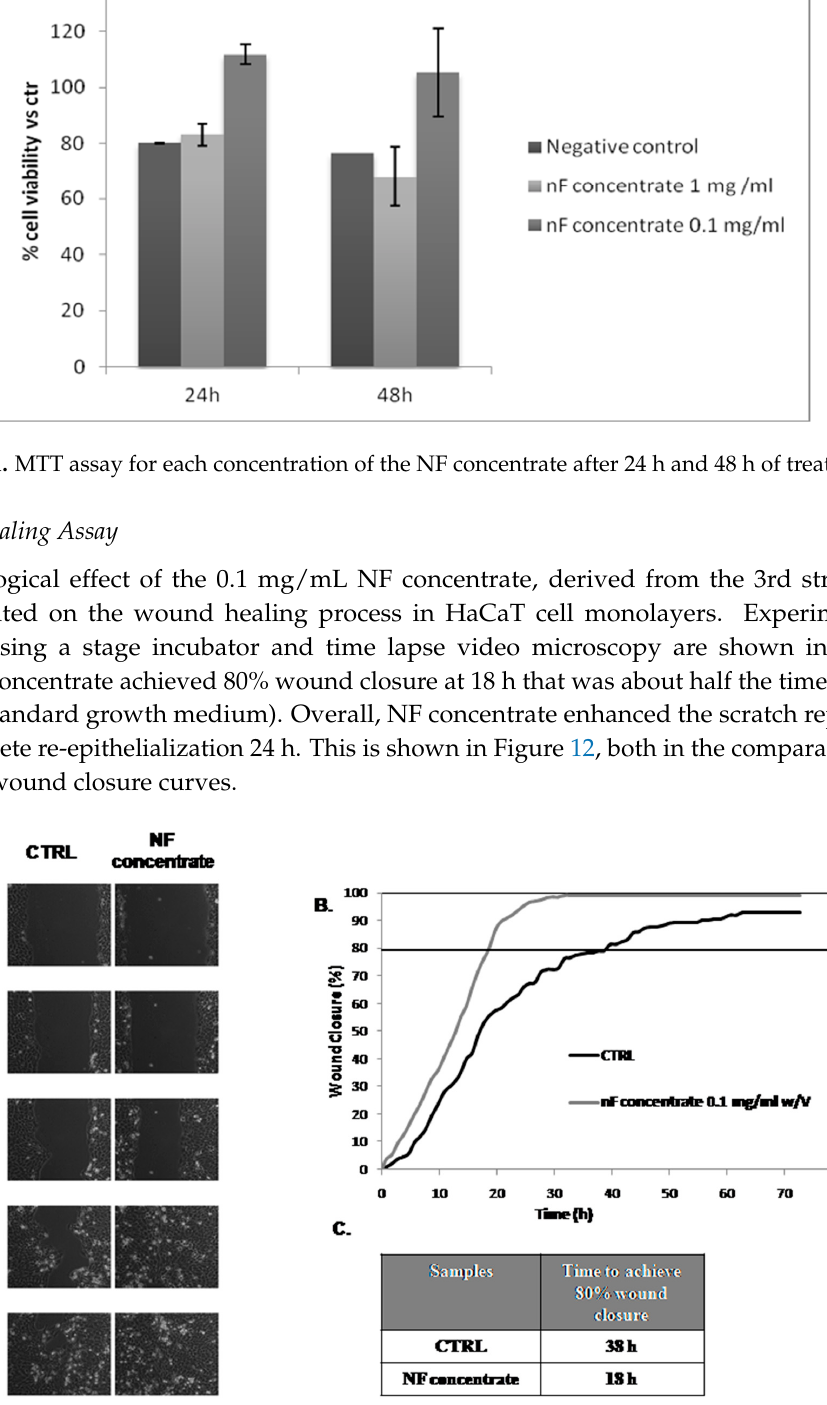
Figure 12. ( A ) Representative panel of comparison of wound repair with and without NF concentrate 0.1 mg/mL w / v at different times. ( B ) Repair represented by wound area reduction with time [as (Area t 0 − Area t/Area t 0 ) × 100] for the control and in presence of 100 for the control and in presence of NF concentrate. The curves are averages of three independent experiments with standard deviation within 5% of the value. ( C ) Average time to achieve 80% wound repair in the presence of NF concentrate 1 mg/mL compared to the